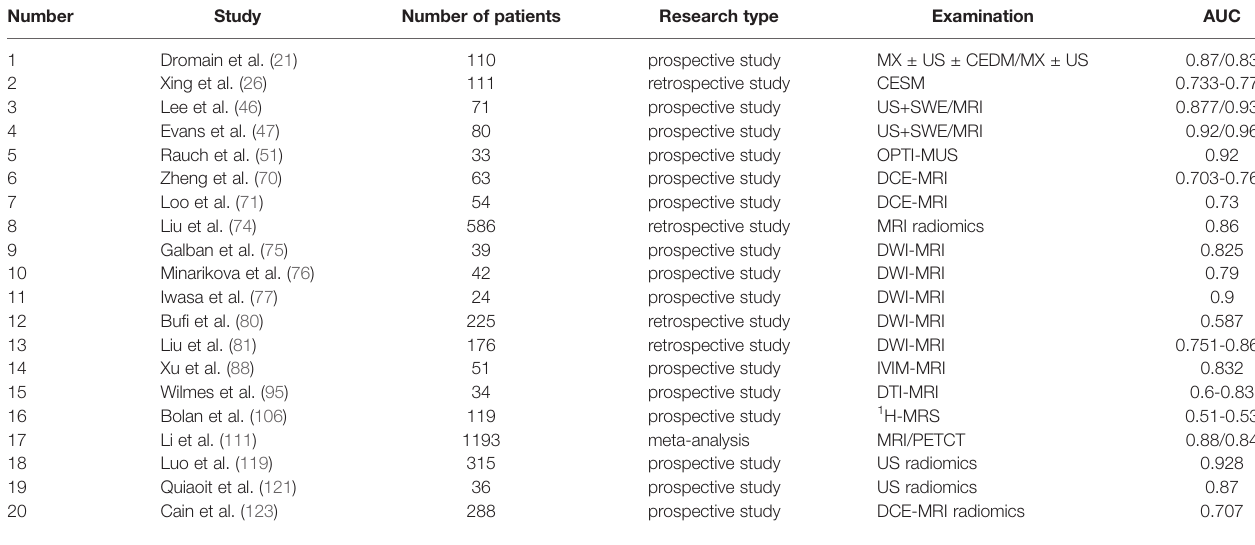
TABLE 1C | Studies on the ef fi cacy of various imaging techniques for breast cancer NAC (References to this article) (C) Studies on the ef fi cacy of various imaging techniques on NAC in breast cancer (evaluation index: